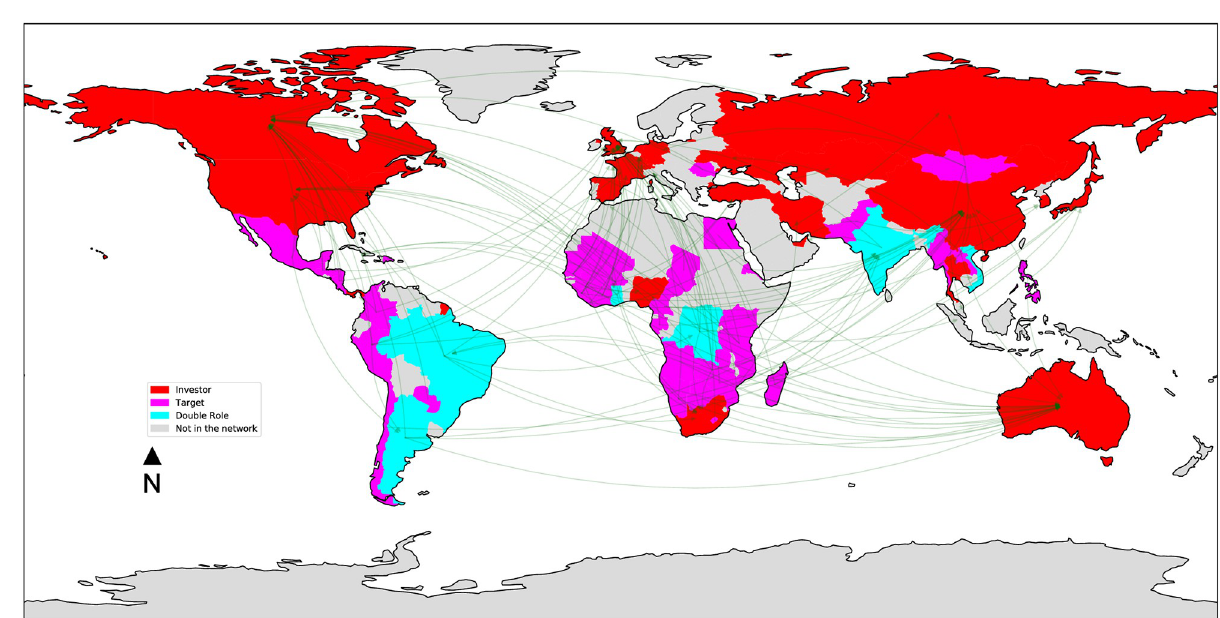
Fig 6. The mines land trade network, where countries are colored based on their role: Source nodes/pure investors (red), sink nodes/pure targets (magenta), double role countries (cyan). Countries colored in grey are absent from the network.